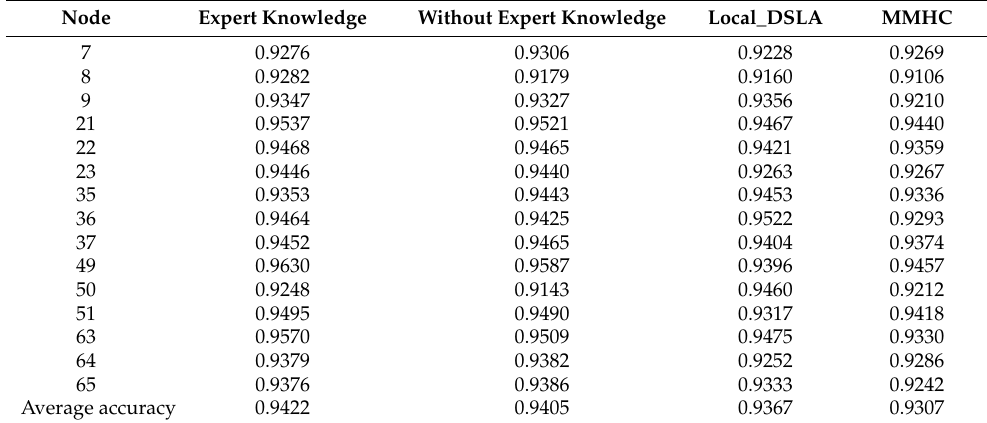
Table 7. Diagnostic accuracy of different BN.